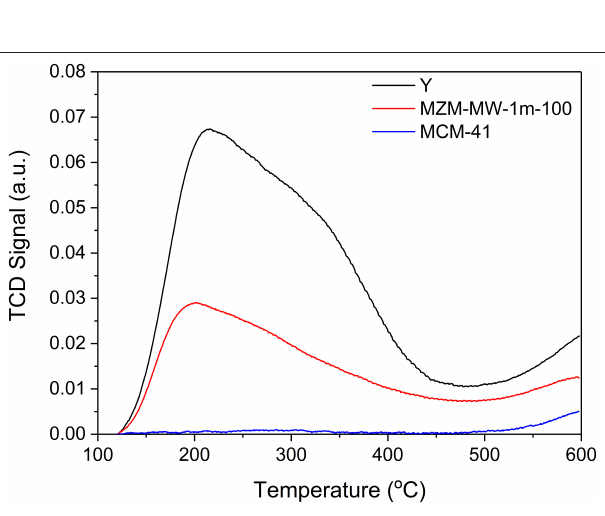
FIGURE 5 | NH 3 -TPD profiles of the parent zeolite Y, MZM-MW-1m-100, and